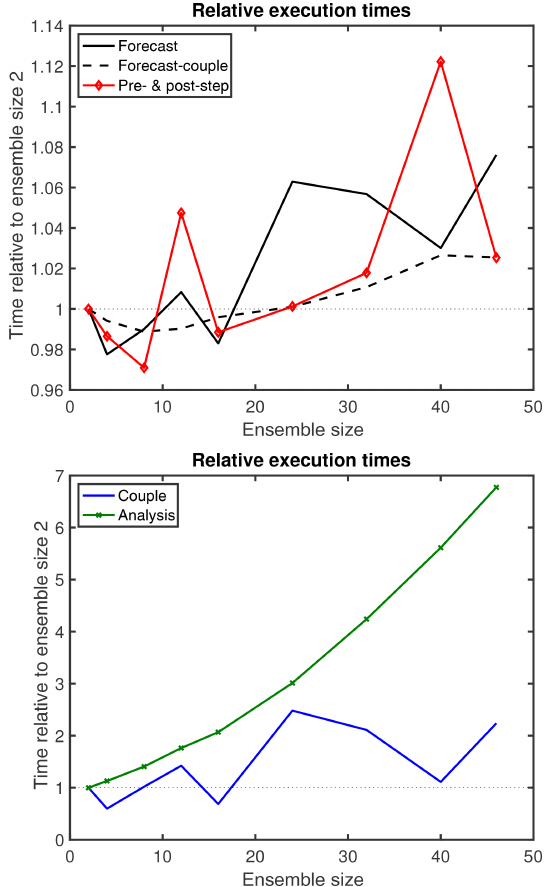
Figure 6. Execution times relative to ensemble size 2 for different parts of the assimilation program as a function of the ensemble size. The fluctuation in the time is caused by parallel communication and file operations. The analysis step shows a systematic time increase, while the time for DA coupling varies